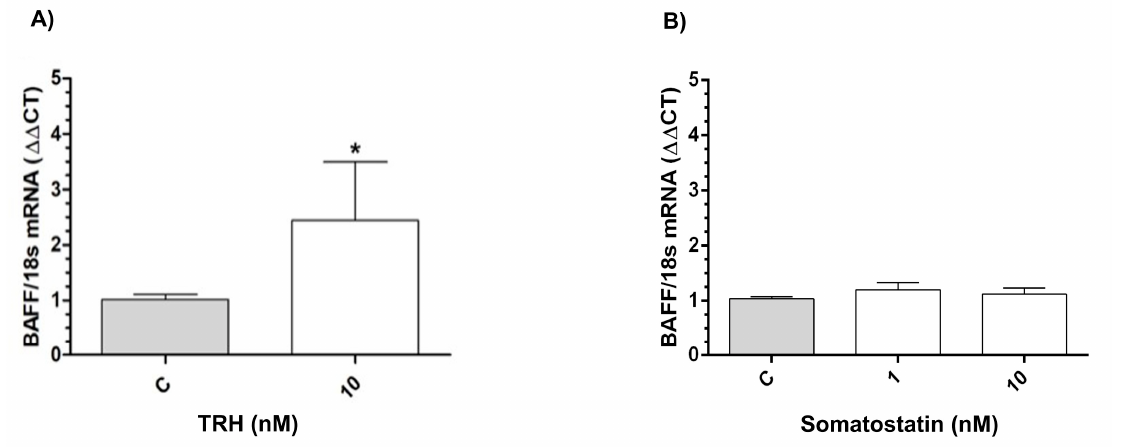
Figure 8. Effects of TRH and SST upon pCREB. Phosphorylation of CREB in serine-133 was analyzed after one-hour treatment with TRH ( A ), SST ( B ), or the combination of both hormones ( C ) in B-bursal cells. Representative immunoblots show the immunoreactive bands to pCREB S133 (37 kDa), as determined by SDS-PAGE followed by Western blot and densitometry. β Actin was used as loading and normalizing control in all cases (42 kDa). Each bar represents mean ± SEM. Data was obtained from three independent experiments and expressed as relative percentage in relation with the control group (%). The groups with asterisks are significantly different (* p < 0.05), as determined by paired t test.